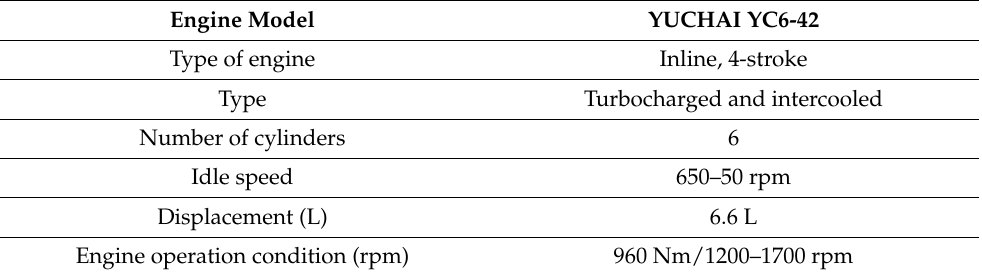
Table 6. Technical specifications of the experimental engine, adapted from Liu et al.